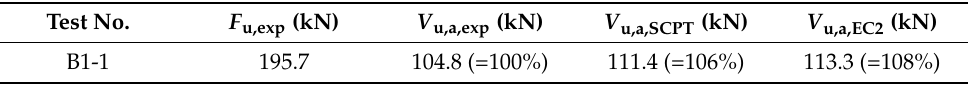
Table 3. Comparison of the experimental shear failure load V u (self-weight neglected) with calculated shear failure loads according to the Shear Crack Propagation Theory (SCPT) and current EC2. Test No.